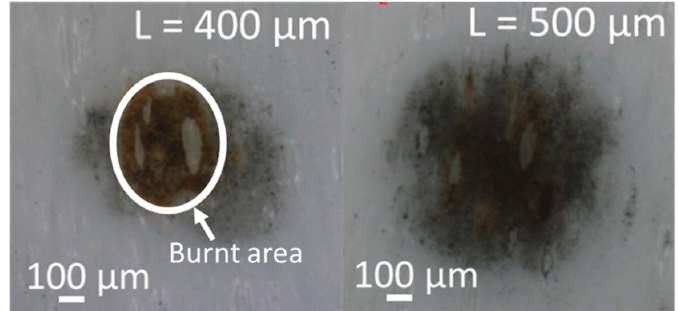
Figure 7. Example of an experimental result for (left) distance L = 400 µm and (right) distance L = 500 µm. The density of the nickel particles (black area) increased as the deposition diameter was enlarged.